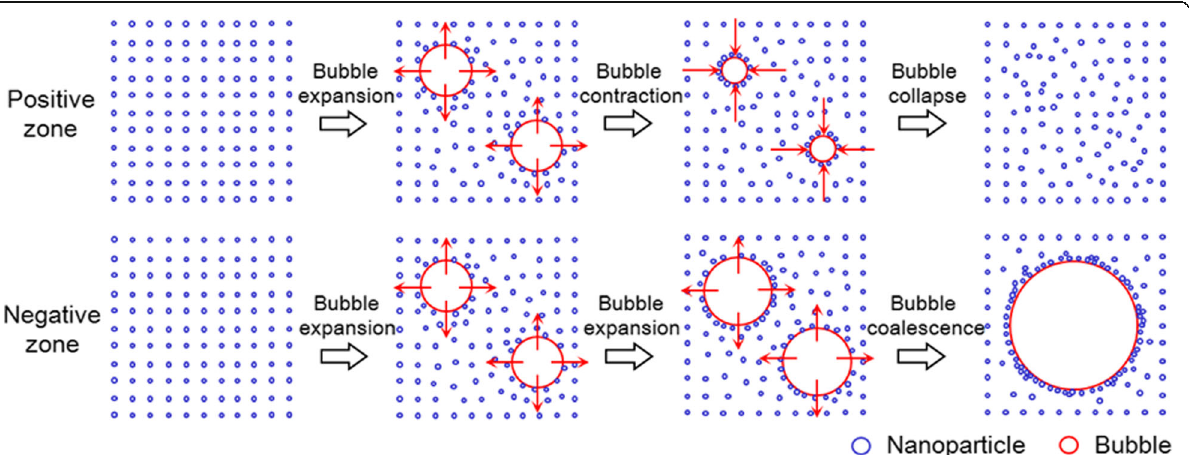
Fig. 8 A schematic diagram showing the cavitation bubbles formed in the positive and negative